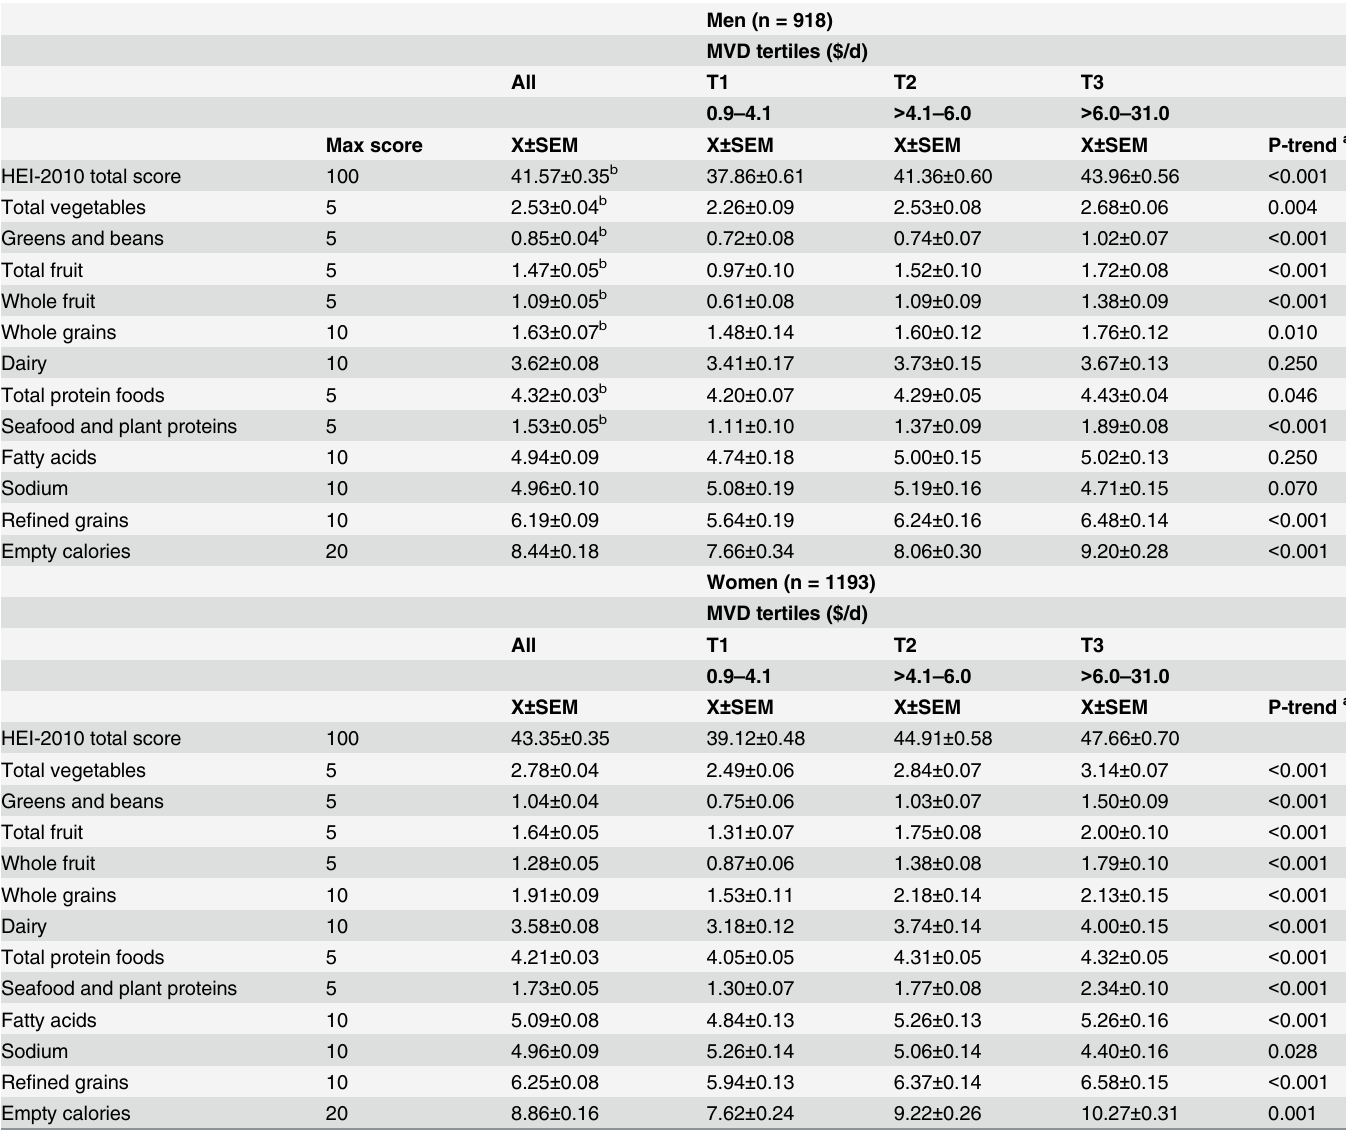
Table 2. HEI-2010 total score and components a for HANDLS participants by monetary value of diet tertile and sex.